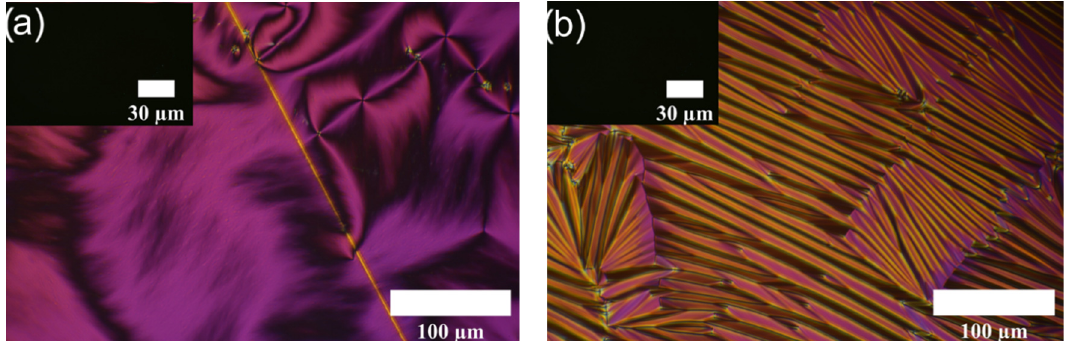
Figure 7. In symmetric cells treated with dimethyloctadecyl [3-(trimethoxysilyl) propyl] ammonium chloride (DMOAP), CB7CB displays a degenerate planar anchoring in the N phase ( a ) giving rise to unoriented stripes in N TB phase ( b ). On the contrary, the mixture φ = 38.42 wt % shows a very good homeotropic alignment in both N (( a ), inset ) and N TB (( b ), inset ) phases. Polarized optical micrographs, crossed polarizers.